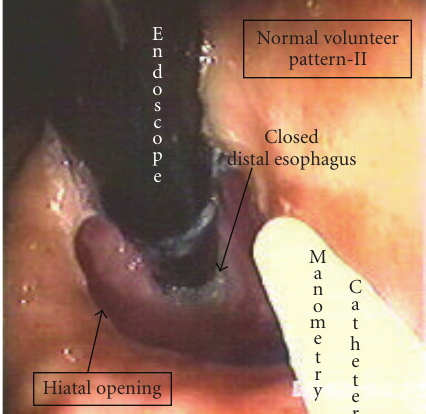
Figure 4: This is pattern II opening. This picture shows a retroflexed view of the gastroesophageal junction in a normal volunteer. The white catheter is the manometry catheter and the black tube is the endoscope. Note that the hiatus is open around the endoscope during air insu ffl ation into the stomach but that the distal esophagus remains closed and tight around the endoscope. This subject did not have a hiatal hernia, and the esophagus was tight around the endoscope prior to air insu ffl ation.